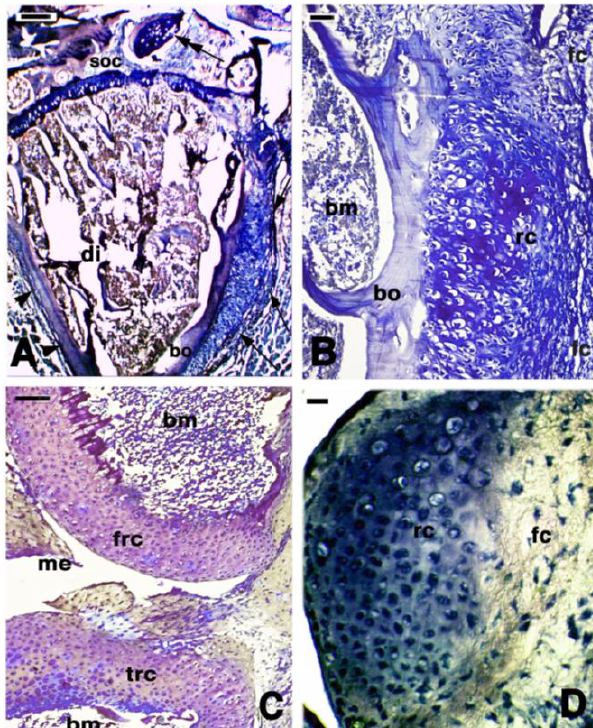
Figure 4. Cartilage regeneration after small injuries in the tibia ( A , B ) or knee ( C , D ) in P. muralis . ( A – D , Methylene blue—Eosin stain). ( A ) the injury in the lateral periosteum located along the right diaphyseal bone has produced the formation of a cartilaginous tissue after 32 days (arrows). Also the articular cartilage has been injured by the surgical damage and a small cartilaginous nucleus is seen within the secondary ossification center (double arrow). The arrowheads point to the contralateral, untouched periosteum. Bar, 50 μm; ( B ) detail of the cartilaginous cushion formed between the diaphyseal bone and the external fibrous connective. Bar, 20 μm; ( C ) at 28 days post-injury of the knee, a large cartilaginous tissue replaces most of the secondary centers of the epiphyses. Bar, 50 μm; ( D ) detail on the numerous cells forming the regenerated cartilage originated inside the secondary ossification center (see position indicated by the double arrow in A). Bar, 20 μm. Legends: bm, bone marrow; bo, bone; di, diaphysis; fc, fibrous connective; frc, regenerated cartilage of the femur; me, meniscus; rc, regenerated cartilage; soc, secondary ossification center. In the regenerating epiphyses at 21 and 32 days post-injury, 5BrdU-labeled cells are numerous not only in the superficial articular cartilage and growth plate but also in the inner mass of